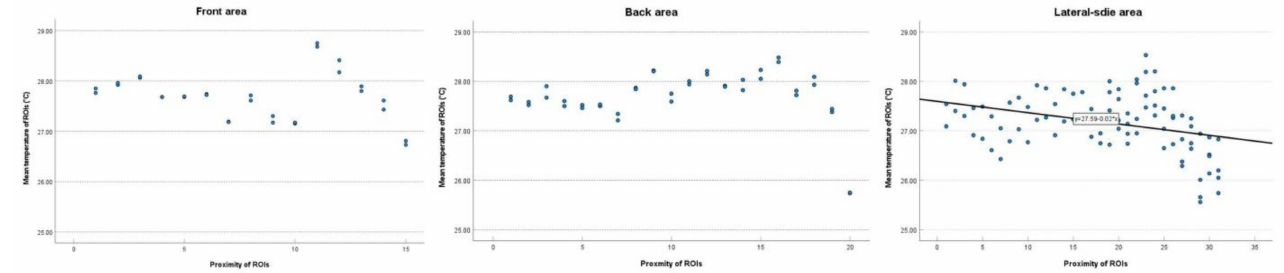
Figure 4. Relation between the mean temperature of the region of interest (ROIs) and the proximity of ROIs in three areas according to regression analysis. Front area temperature = 27.871 − (0.023 × ROIs) ( p = 0.260, R 2 = 0.045); back area temperature = 27.792 − (0.009 × ROIs) ( p = 0.569, R 2 = 0.009); lateral- side area temperature = 27.595 − (0.023 × ROIs) ( p = 0.001, R 2 = 0.114). In terms of | ∆ T| according to the proximity of ROIs, the | ∆ T| tended to increase from the proximal to the distal part in only the front area ( p = 0.047, regression analysis), not in the back or lateral-side areas (Figure